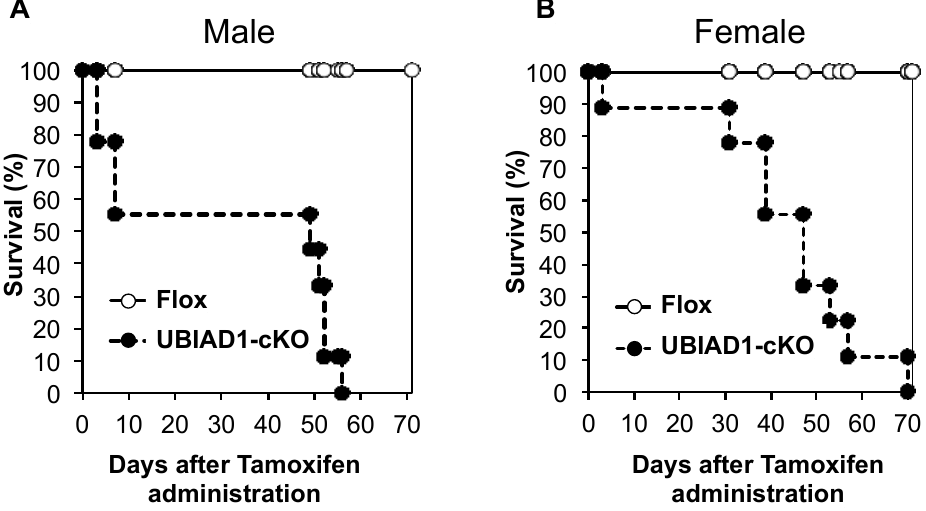
Figure 1. Kaplan–Meier survival curves of male (a) and female (b) Flox and UbiA prenyltransferase domain-containing protein 1 knockout (UBIAD1-cKO) mice after administration of tamoxifen.